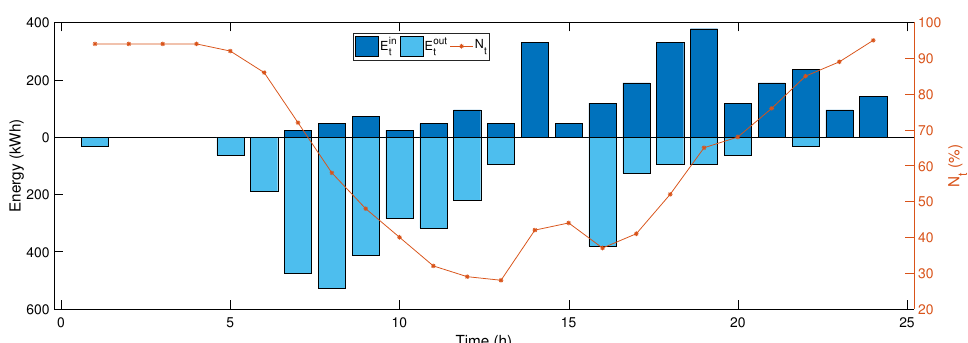
Figure 2. Expected values of the percentage of EVs plugged into the parking lot and total amount of energy arriving at, and departing from, the parking